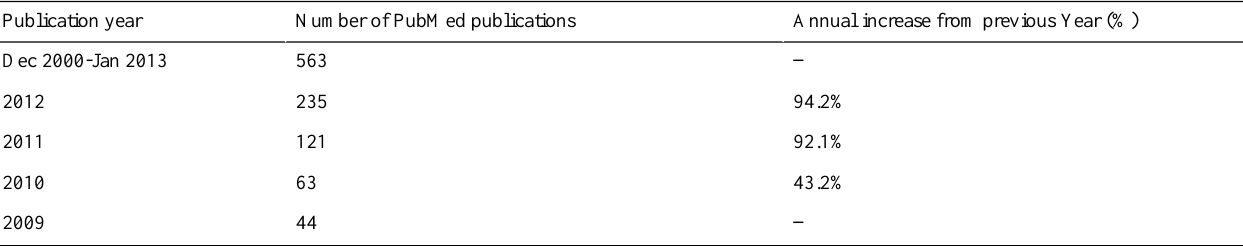
Table 1. SMS articles published between December 2000 and January